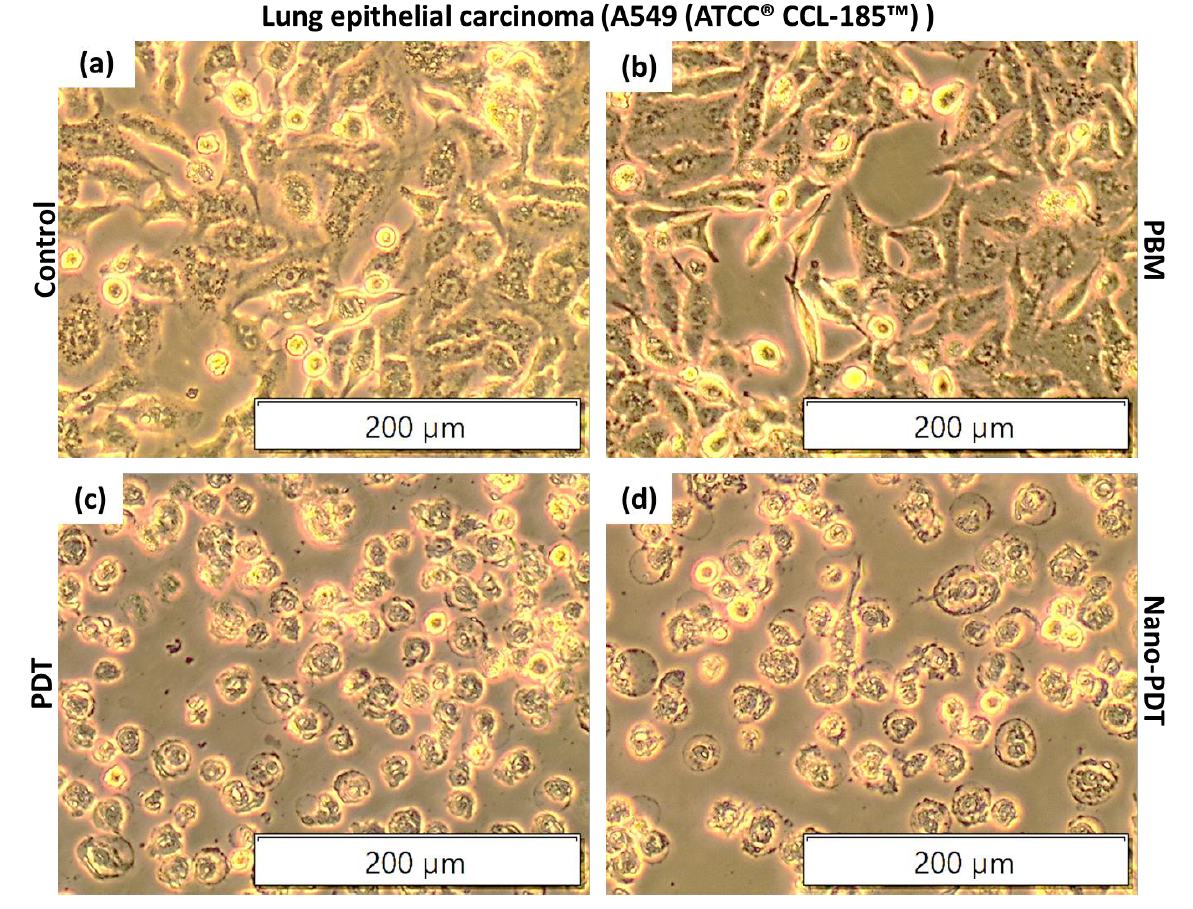
Figure 2. Morphology of lung epithelial carcinoma cells (A549) 24 h post-PDT treatment: ( a ) Control cells receiving no treatment. ( b ) Cells receiving PBM of 10 J/cm 2 with a wavelength of 660 nm. ( c ) Cells receiving PDT treatment using 20 µM AlPcS 4 Cl and 10 J/cm 2 irradiation. ( d ) Cells receiving nanoPDT treatment using the AlPcS 4 Cl-goldnano bioconjugate.